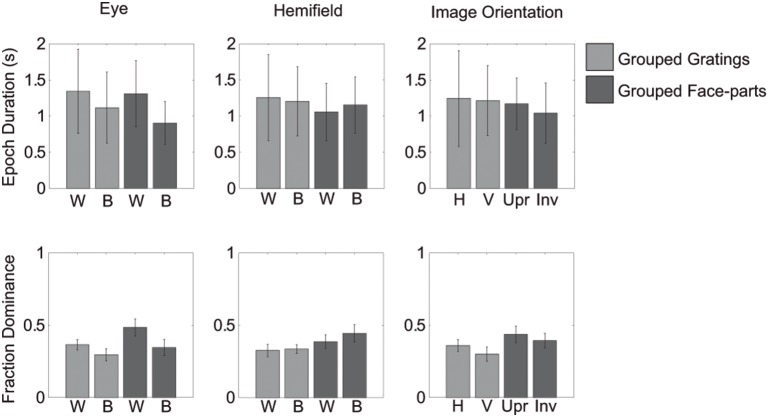
Main effects of Experiment 1.Overview of main effects of within- versus between eye dominance, within- versus between hemifields and image orientation for grouped gratings (light grey) and grouped face-parts (dark grey). Error bars represent the 95% confidence intervals. The 3 top panels depict the average median epoch duration in seconds. Each participant’s data was normalized using his or her overall median dominance duration. After averaging across participants the averages were multiplied by the overall median across all participants, which results in a duration in seconds. Note that this normalization used was only for graphical purposes. The other 3 panels depict the fraction of overall dominance. The different conditions are denoted on the abscissa as follows W: within- eye/hemifield, B: between- eye/hemifield, H: horizontal, V: vertical, Upr: upright, Inv: Inverted.